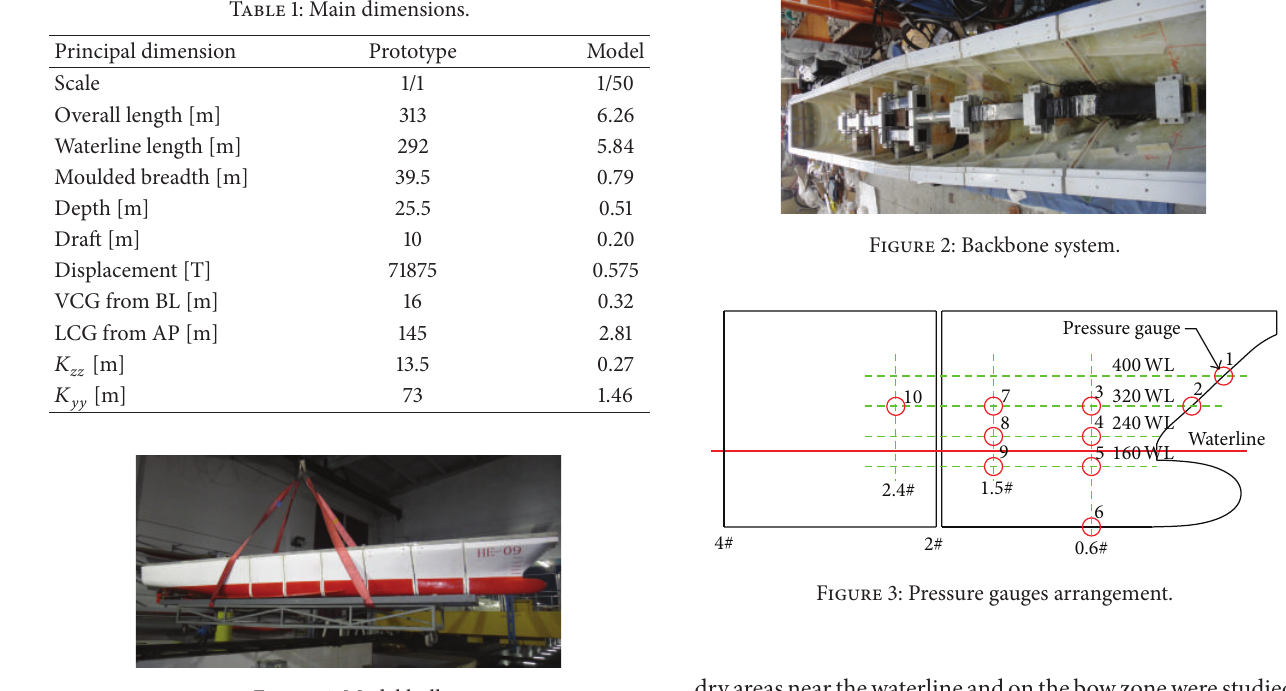
Figure 1: Model hull.